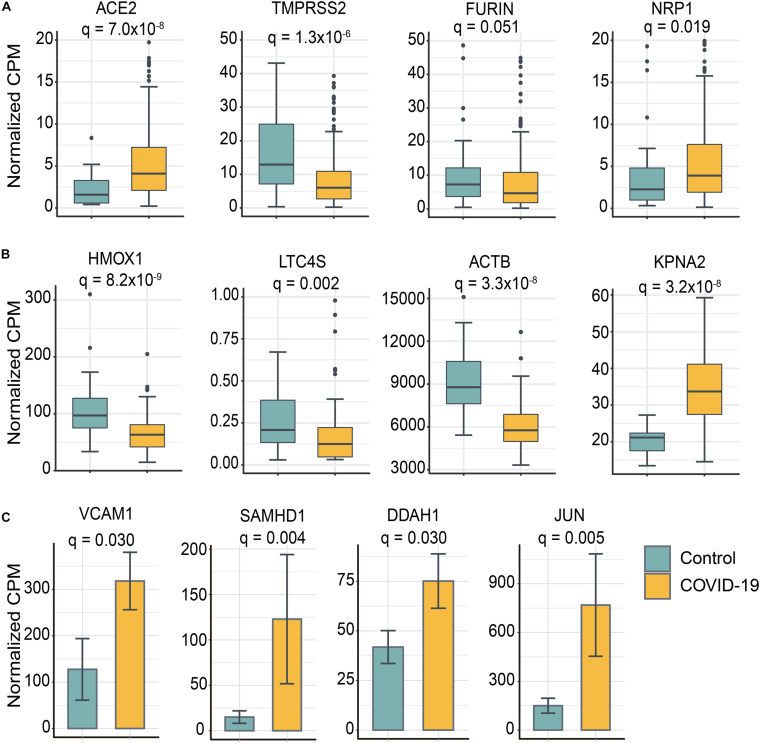
Selected genes involved in COVID-19-associated stroke were differentially expressed between SARS-CoV-2 positive patients and controls. (A) Four SARS-CoV-2 entry host factors were significantly differentially expressed in nasal tissues from COVID-19 positive patients compared to controls. (B) Stroke-related genes were differentially expressed in peripheral blood mononuclear cell (PBMC) samples from COVID-19 positive patients and controls. The data are represented as a boxplot where the middle line is the median, the lower and upper edges of the box are the first and third quartiles, the whiskers represent the interquartile range (IQR) × 1.5. (C) The bar plot shows the stroke-related genes were upregulated in iPSC–cardiomyocytes after SARS-CoV-2 infection. Adjusted p-value (q) were computed by Benjamini-Hochberg method. The cutoff of differentially expressed genes were | log2-fold change| > 0.5 and adjusted p-value (q) < 0.05 (Supplementary Tables S5–S8).